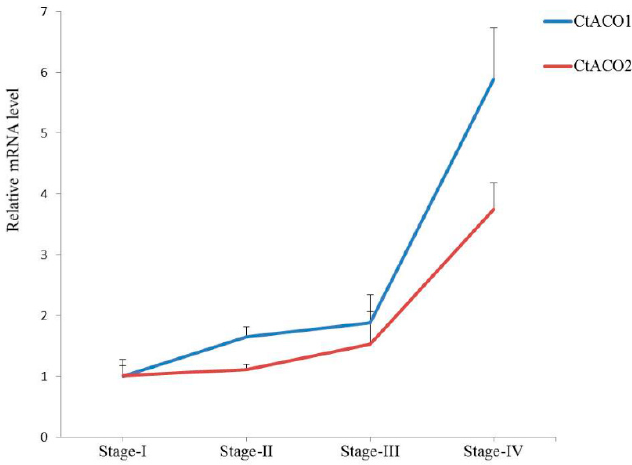
Figure 2. Expression patterns of CtACO1 and CtACO2 in flower stage I, stage II, stage III and stage IV.